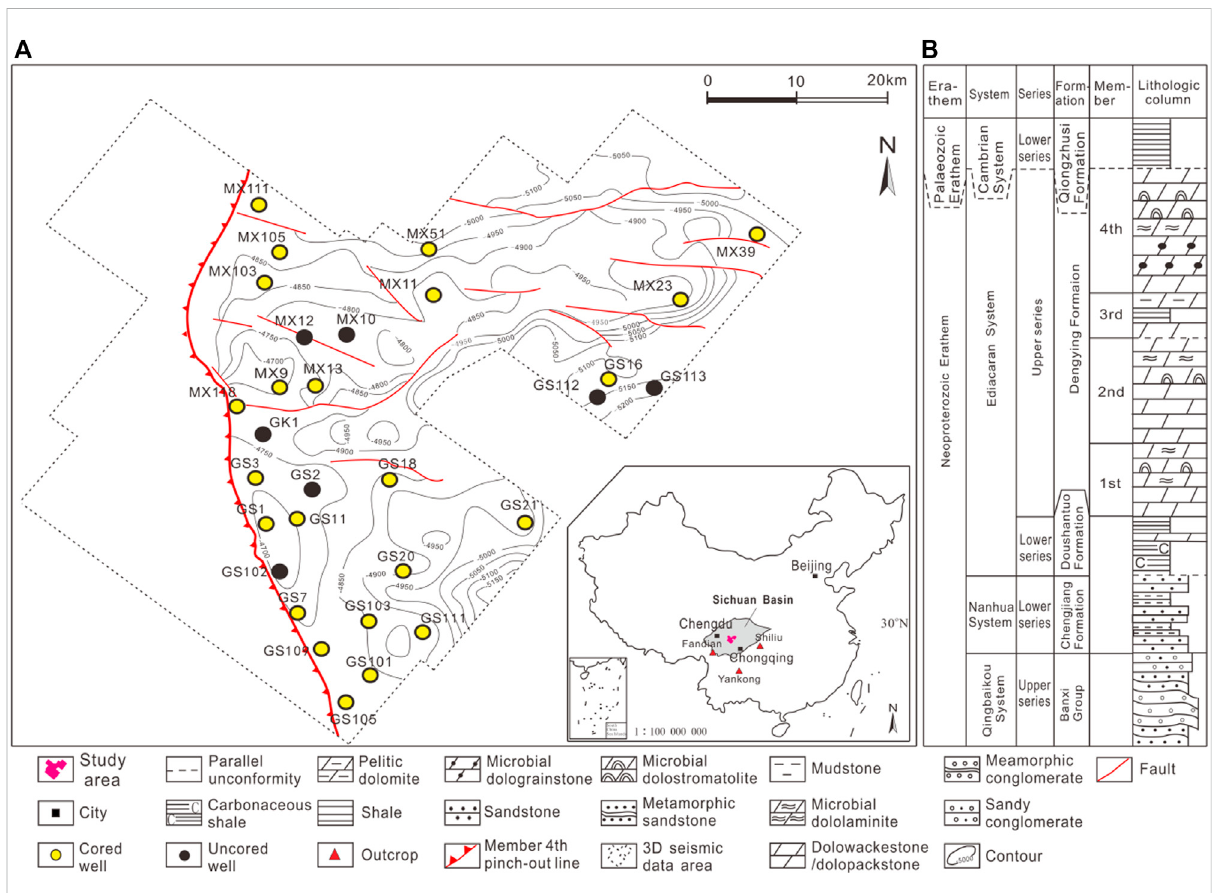
FIGURE 1 (A) The spatial distribution map showing the study area and drilling wells in the Central Sichuan Basin. (B) Generalized stratigraphy of the Ediacaran Dengying Formation in the study area (modi fi ed from Gu et al.,